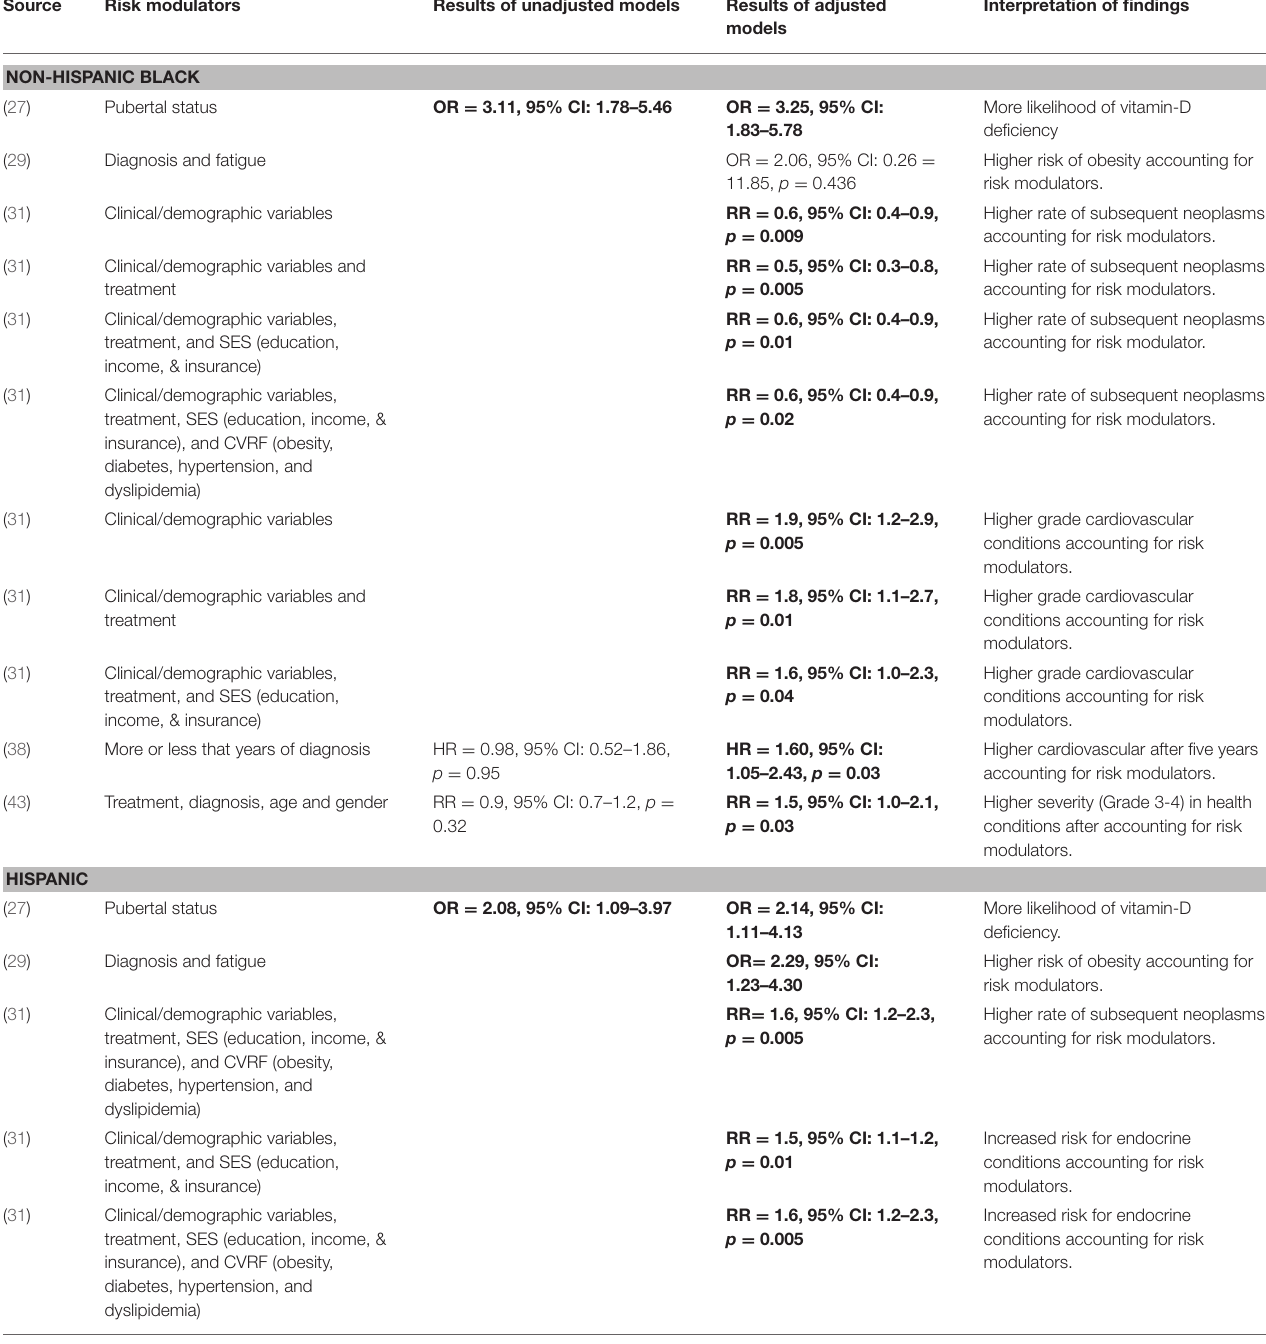
TABLE 4 | Factors influencing disparities in chronic health conditions for childhood cancer survivors by